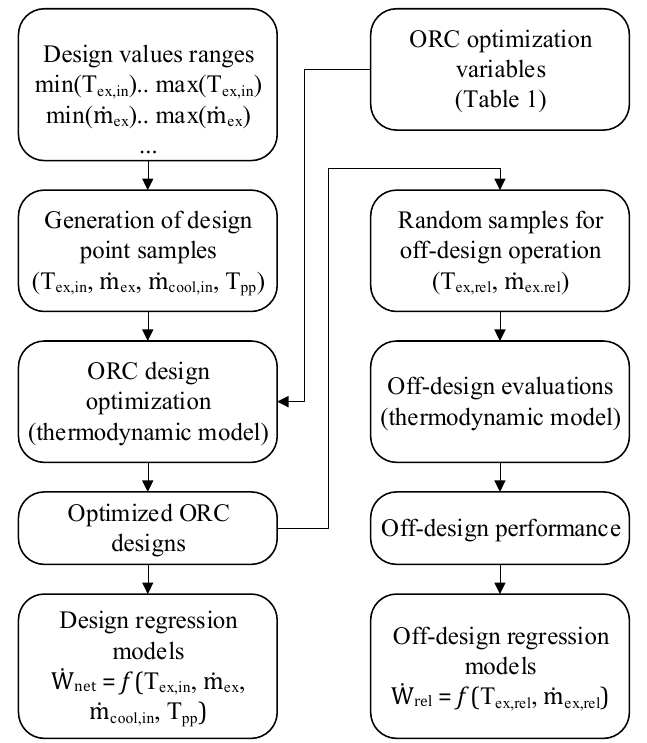
Figure 3. Procedure used to derive the ORC performance regression models.